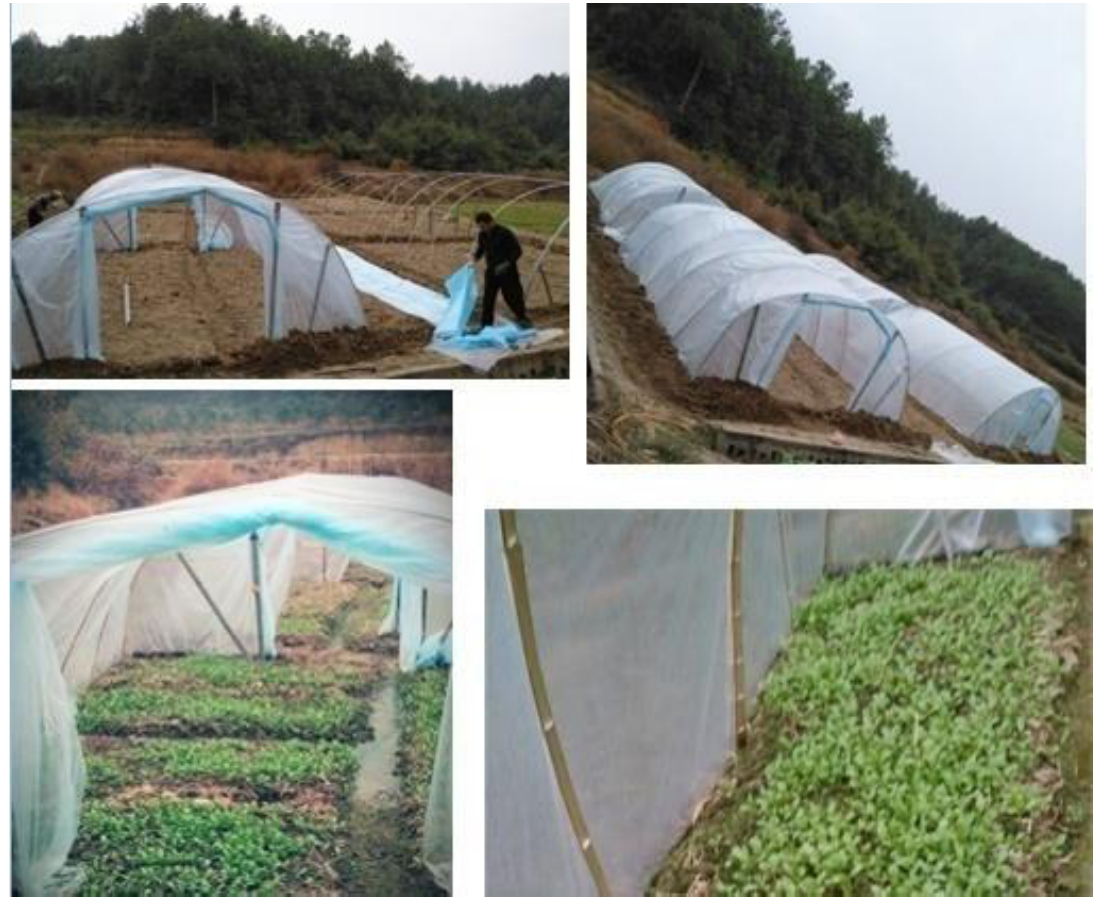
Figure 2. Setting of test sheds.